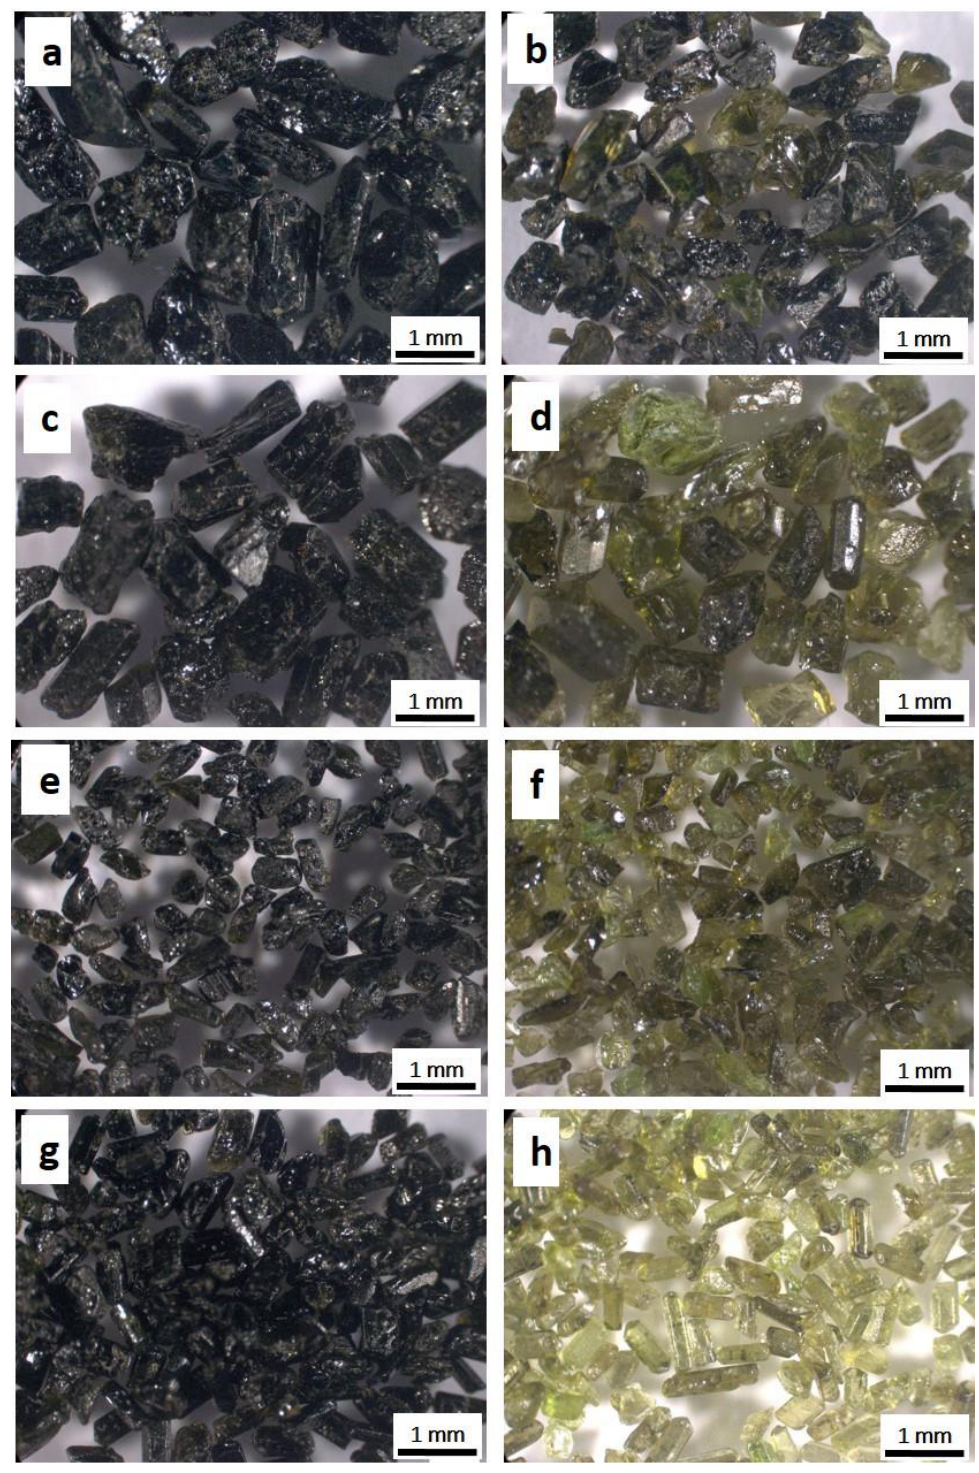
Figure 3. Separated clinopyroxene crystals selected for the isotopic analyses. ( a , b ): dark- and light- green crystals separated from the granulometric fraction between 0.25 and 0.50 mm of sample OFA-3b; ( c , d ): dark- and light-green crystals separated from the granulometric fraction between 0.25 and 0.50 mm of sample OFA-13bis; ( e , f ): dark- and light-green crystals separated from the granulometric fraction between 0.25 and 0.355 mm of sample OFA-3b; ( g , h ): dark- and light-green crystals separated from the granulometric fraction between 0.25 and 0.355 mm of sample CA.